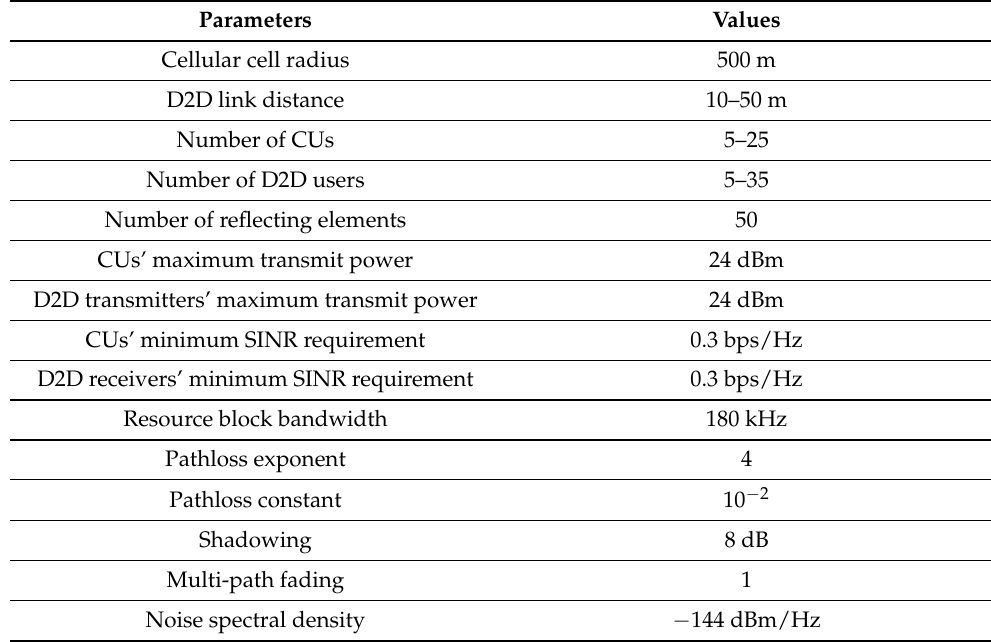
Table 1. Simulation Parameters for IRS-aided D2D